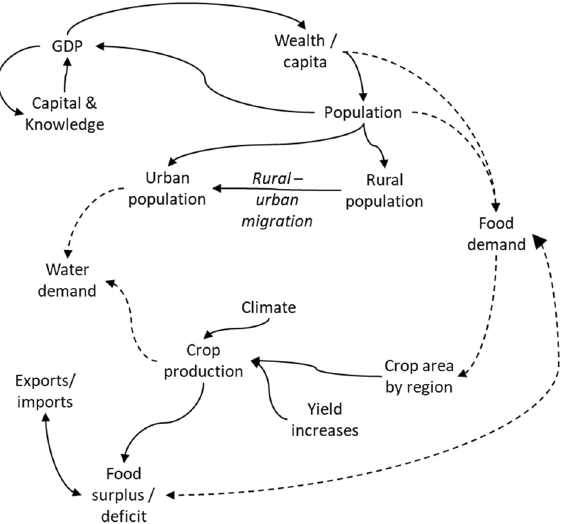
Figure 2. Schematic diagram of the population – GDP – food – water model. The names represent a quantity that is simulated by a sub-model or, in the case of climate, an input sourced from an external model. The lines indicate links amongst sub-models, with dashed lines indicating links that represent a demand for food or